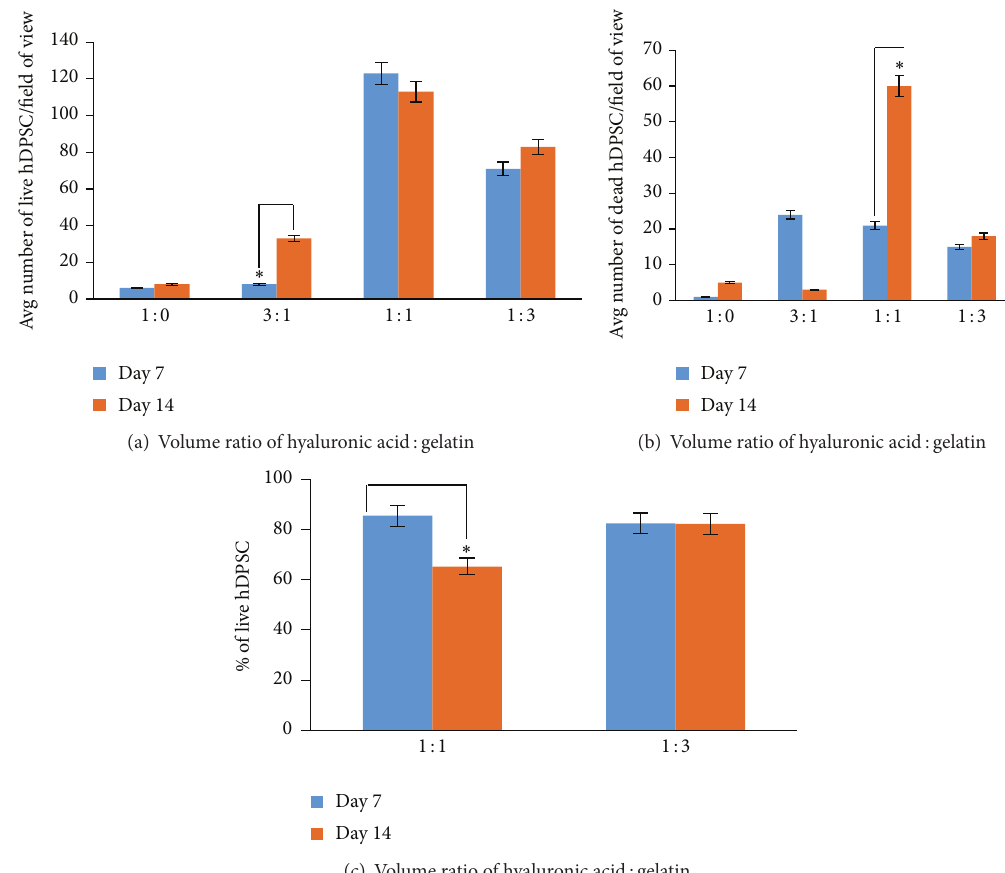
Figure 3: (a-b) The average number of live and dead hDPSC per field of view as a function of (v/v) ratio of HA: GN. (c) The percentage of live hDPSC in the 1:1 and 1:3 (v/v) ratios of HA:GN. ∗ 𝑝 < 0.05 .